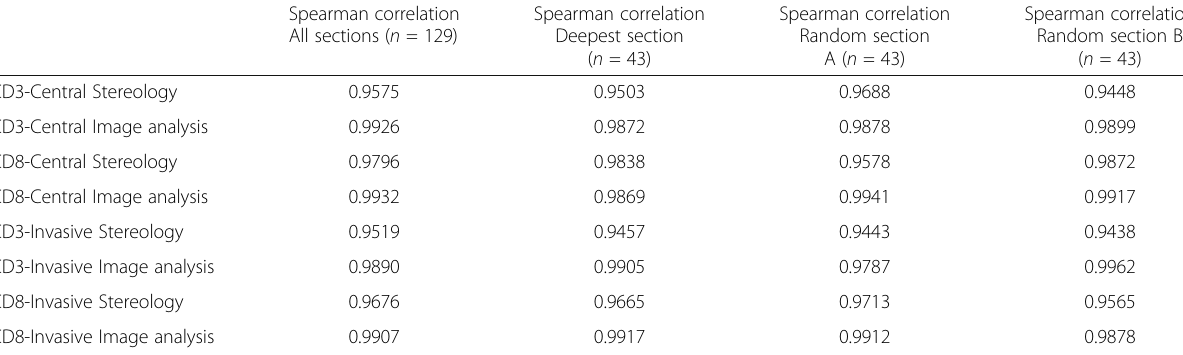
Table 5 Correlation between numerical density and area fraction